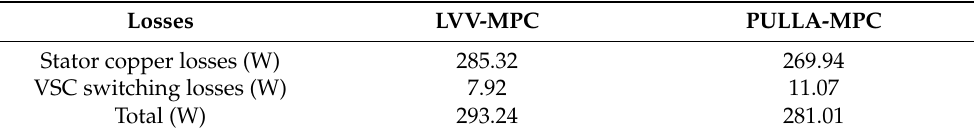
Table 4. Electric drives losses.